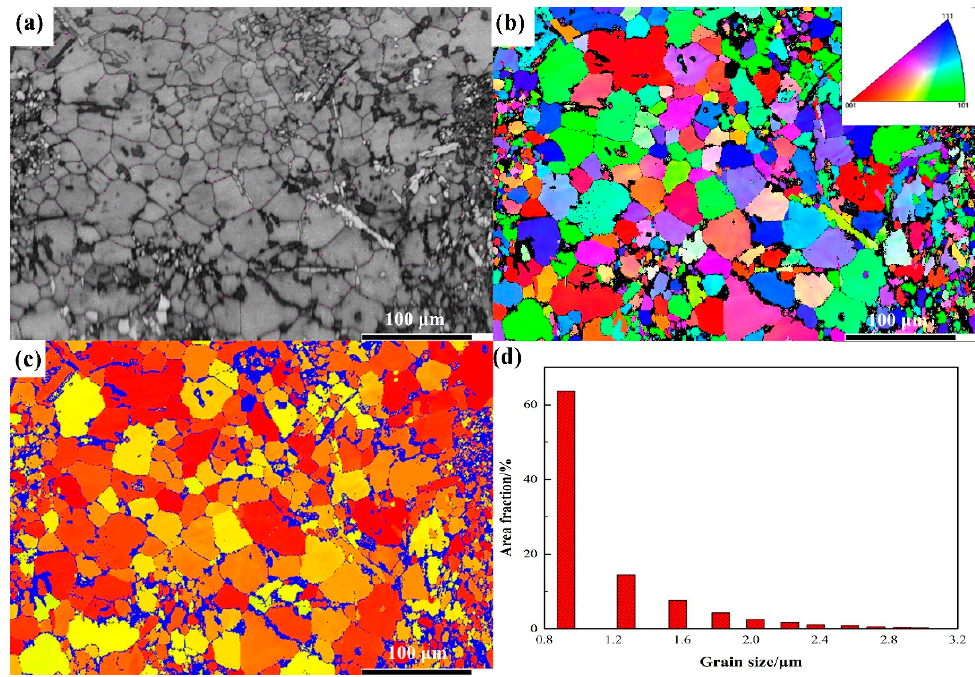
Figure 5. ( a ) Band contrast (BC) map superimposed by twin boundaries (purple lines) of AlCrFeNiV. ( b ) corresponding EBSD IPF subset maps. ( c ) corresponding Taylor Factor maps and ( d ) histogram of grain size distribution.